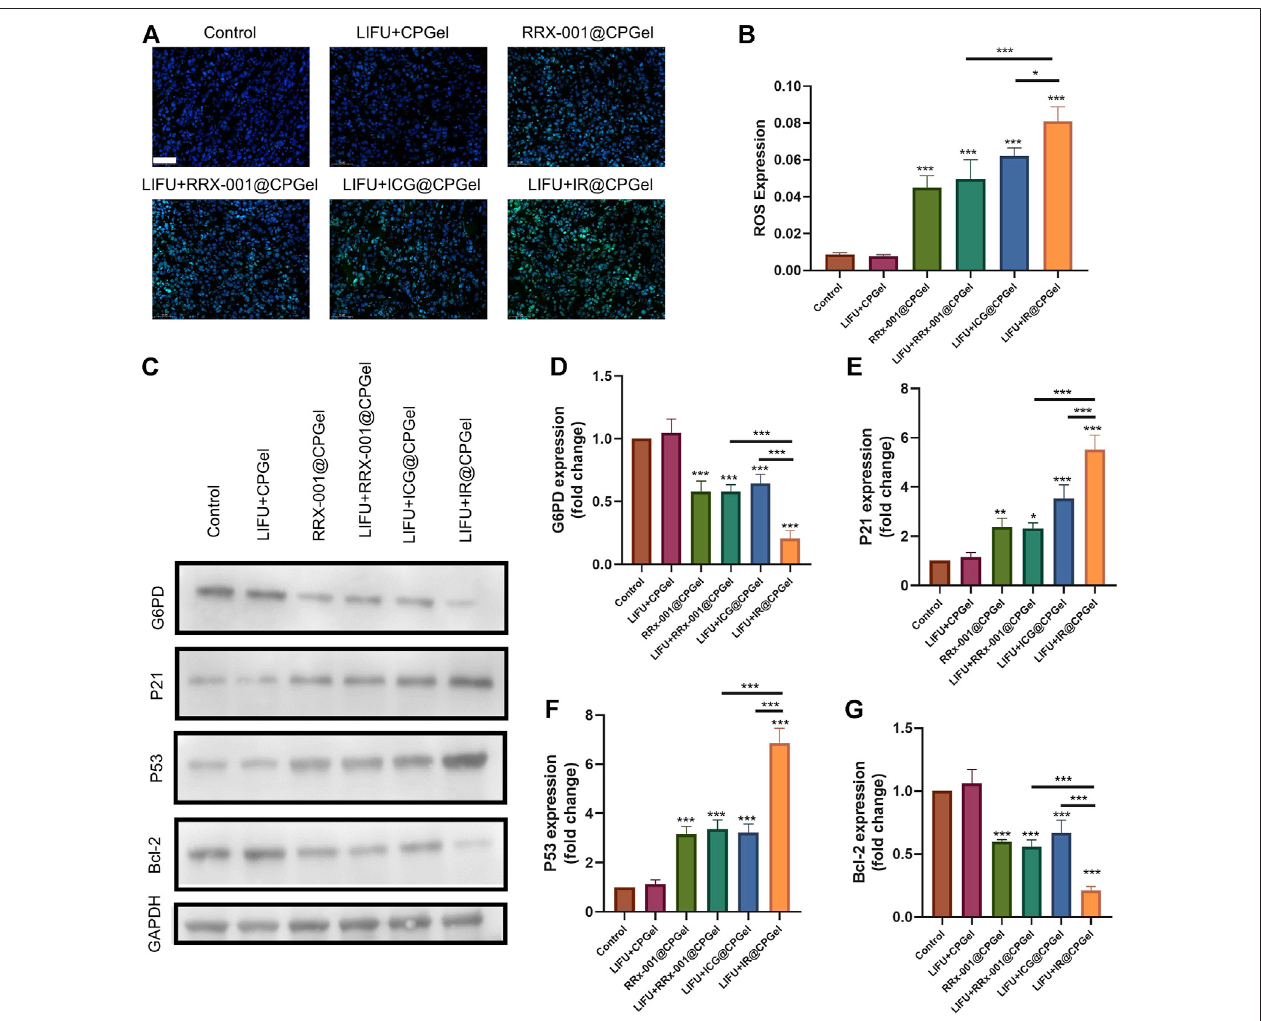
FIGURE 4 | Antitumor mechanism of IR@CPGel. (A) ROS levels in mouse tumors treated with different formulations; scale bar = 50 µm. (B) Semiquantitative analysisofROSlevelsinmousetumorstreatedwithdifferentformulations. (C) WesternblottinganalysisofG6PD,P21,P53andBcl-2expressionlevelsinmousetumors treatedwithdifferentformulations.Semiquantitativeanalysisof (D) G6PD, (E) P21, (F) P53,and (G) Bcl-2expressioninmousetumorstreatedwithdifferentformulations. All data are shown as the mean ± SD. (n = 3), p p < 0.05, pp p < 0.01 and ppp p < 0.001 vs. Control.